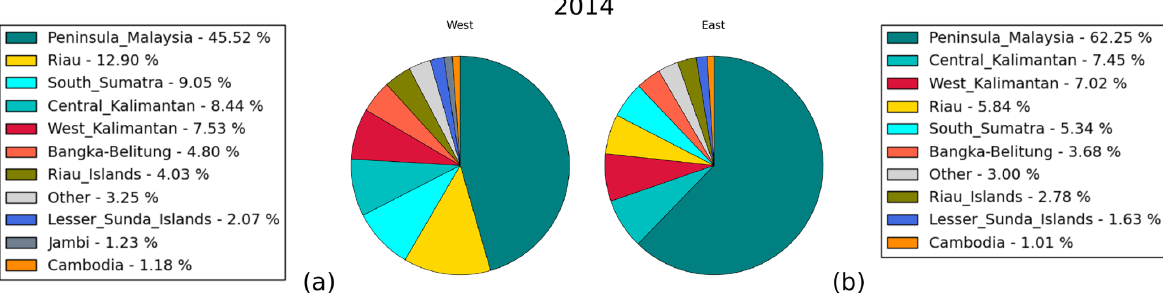
Figure A3. Attribution results for PM 10 for 2014: major contributing source regions for the western (NTU) (a) and eastern (TP) (b) moni- toring